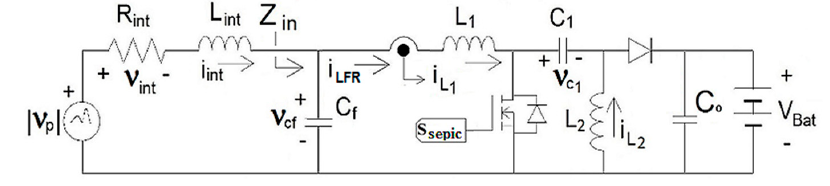
Figure 11. Sepic Converter.